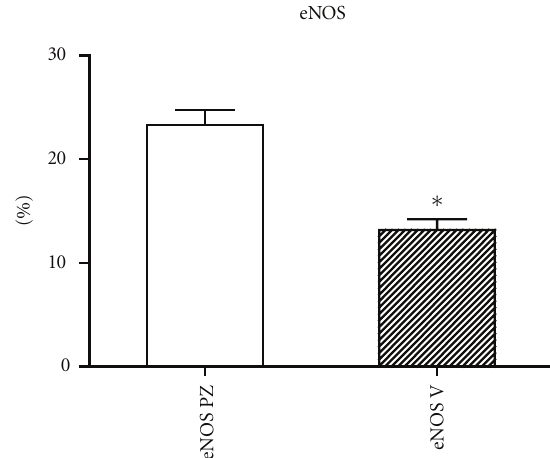
Figure 1: The graph of the morphometric analysis results of the expression of eNOS in varicose and control groups of samples ( P < . 0001).